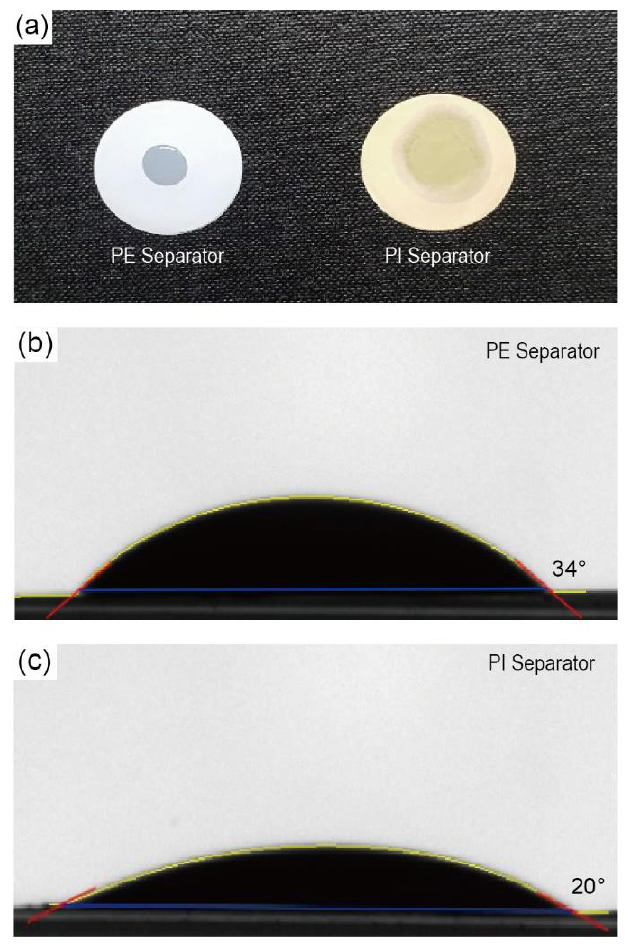
Figure 3. ( a ) A droplet of liquid electrolyte (a mixture of 1.15 M LiPF 6 in ethylene carbonate / ethyl methyl carbonate (EC / EMC) (3 / 7 by vol.)) was dropped on the surfaces of the bare PE and porous PI separators, and the contact angle of the liquid electrolyte droplet was measured for ( b ) bare PE separator and ( c ) porous PI separator.